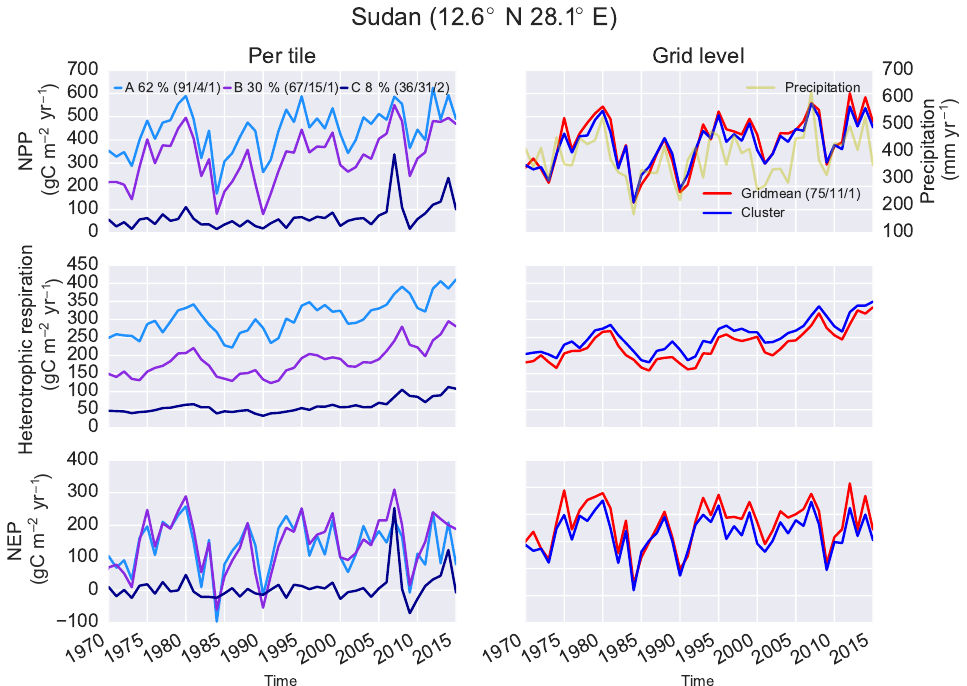
Figure 4. CLASS-CTEM simulated net primary productivity (NPP), heterotrophic respiration, and net ecosystem productivity (NEP; NPP – heterotrophic respiration) for the same grid cell in the Sudan as Fig. 2. The left column shows the model results per tile with soil textures listed as percent sand/clay/OM along with the tile percent grid cell coverage. The right column shows the model results at the grid level for the Cluster simulation (weighted mean average of all tiles) and the Gridmean simulation (simple mean of GSDE soil textures). The annual precipitation for this grid cell from CRU-NCEP is included for reference in the upper right plot.